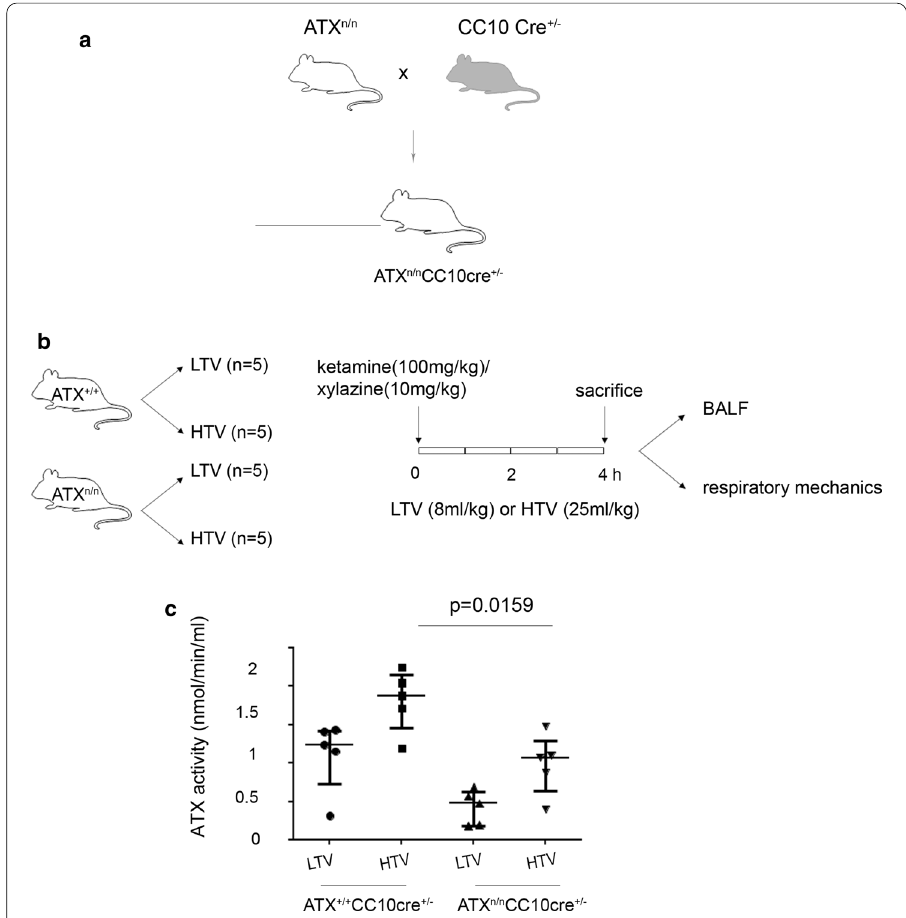
Fig. 2 Tissue-specific deletion of ATX from bronchial epithelial cells reduces BALF activity. a Schematic representation of mating strategy for ATX deletion from Clara cells. b Graphic representation of the experimental groups studied. c Total ATX activity levels in BALF of ATX n/n CC10Cre + /- mice were found downregulated with the TOOS assay. Data are expressed as medians with interquartile range, n group. ATX autotaxin, CC10 Clara cell 10-kDa protein, LTV low tidal volume, HTV high tidal volume, BALF bronchoalveolar lavage